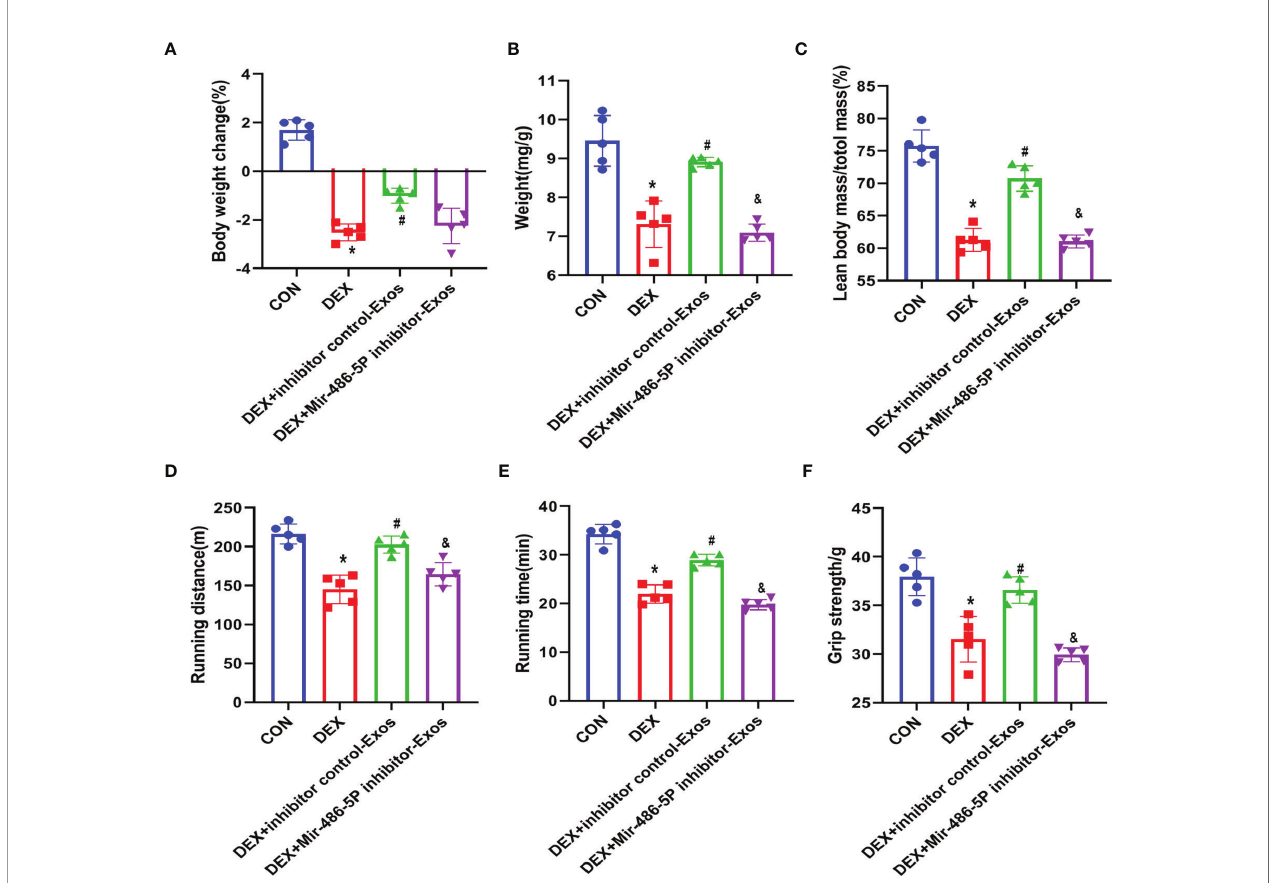
FIGURE 5 | BMSC-Exos inhibited DEX-evoked decline in activity tolerance. (A) Body weight was measured after 14 days of treatment (n = 5). (B) Muscle mass comparison of different groups (n = 5). (C) The ratio of lean body mass to total mass (n = 5). (D, E) Running distance and active time in different groups (n = 5). (F) Grip strength was measured in different groups (n = 5). *p < 0.05 compared to the control group. # p < 0.05 compared to the DEX group. & p < 0.05 compared to the inhibitor NC